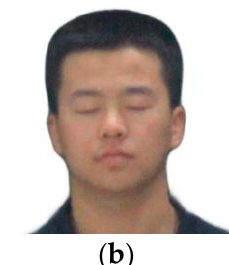
Table 1. Parameters of visible and laser images acquired.